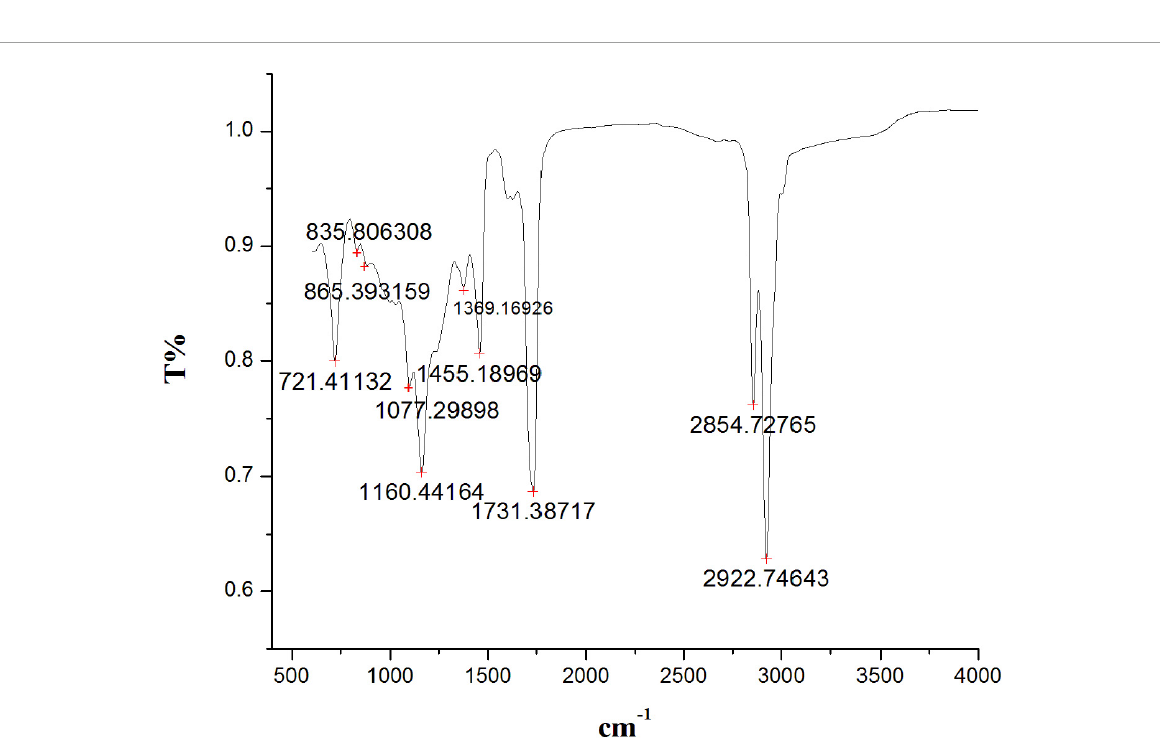
FIGURE2 Fourier transform infrared spectrometer (FTIR) spectrum from n -hexane root extract of Skimmia anquetilia